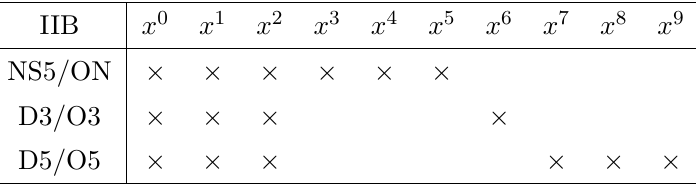
Table 5. The D3-D5-NS5 brane configuration for 3d N = 4 theories. The 2+1 dimensional world- volume theory is realised on the D3 branes. The various orientifolds O3, O5, NS5 are introduced parallel to the respective D3, D5, NS5 brane, i.e. the ON may loosely speaking be considered as orientifold for NS